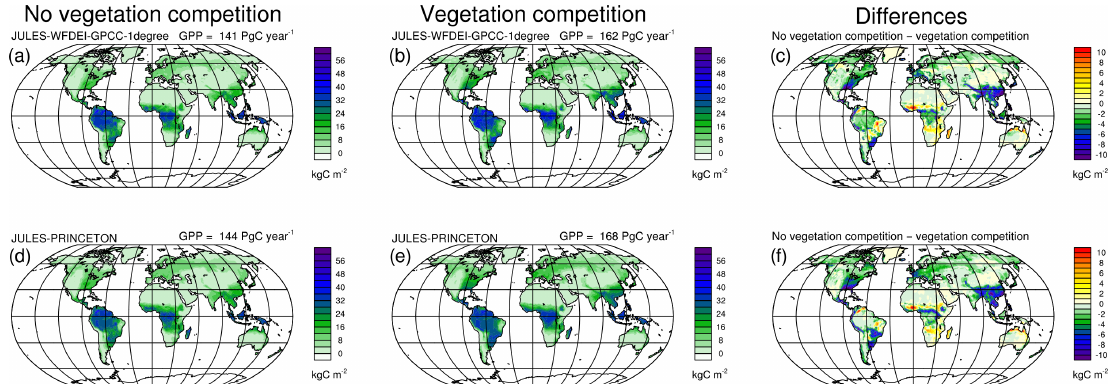
Figure 7. Total annual model-simulated (JULES-WFDEI-GPCC-1degree and JULES-PRINCETON) GPP when simulations were performed with prescribed PFTs (vegetation competition switched off) and with different PFTs competing against each other (vegetation competition switched on) for 2001–2010. Panels (a) and (b) show the total annual JULES-WFDEI-GPCC-1degree GPP with vegetation competition switched off and on, respectively, and (c) shows the difference. Panels (d) and (e) show the total annual JULES-PRINCETON GPP with vegetation competition switched off and on, respectively, and (f) shows the difference. At the top right of (a) , (b) , (d) and (e) , the average annual global GPP for 2001–2010 is